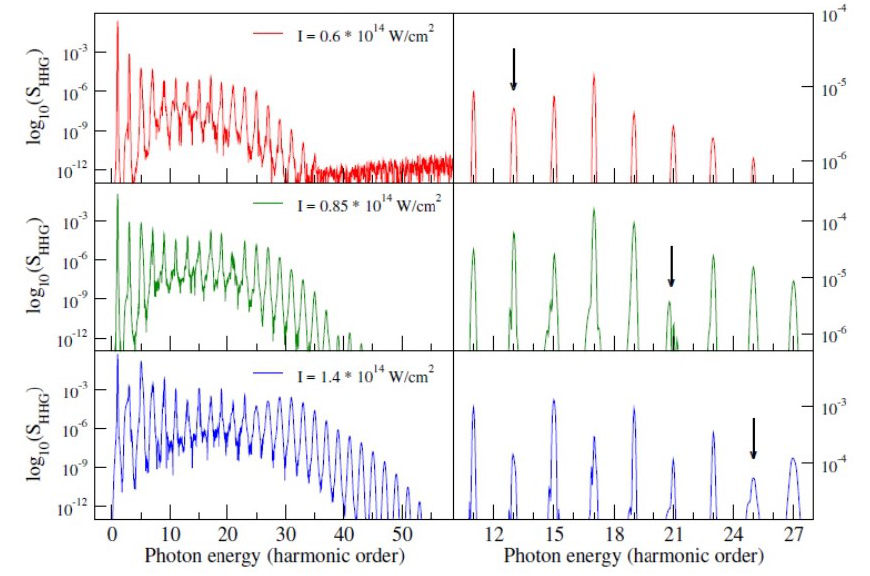
Figure 10. HHG spectra of CO 2 at I = 0.6 × 10 14 (red), 0.85 × 10 14 (green) and 1.4 × 10 14 (blue) W/cm 2